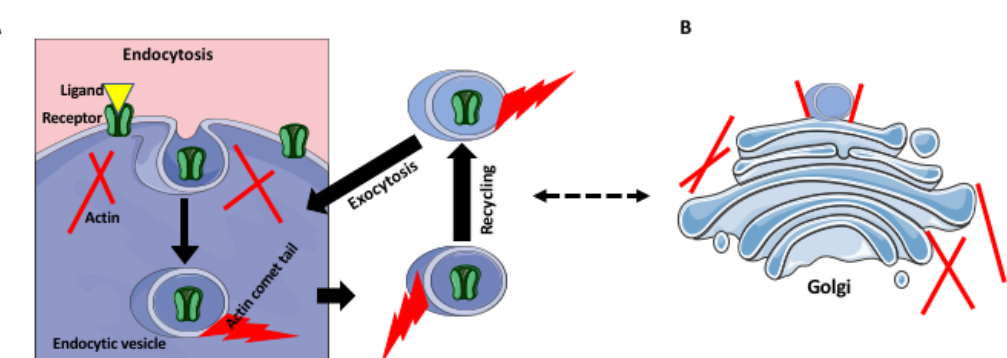
Figure 1. Actin in receptor recycling and Golgi. ( A ) An “used” ligand-bound receptor is internalized by endocytosis. The ligand is released in the acidic interior of the late endosome, and sorted into the lysosome-fusing vesicles. The receptors are sorted into the recycling vesicles and return to the cell membrane. The endocytic vesicles may move using actin comets, which are blocked by the GTPase inhibitors. ( B ) Some surface receptors are also recycled through the Golgi complex, which can exchange components with the endosomal pathway. The Golgi cisternae and budding vesicles are supported and anchored by the actin filaments.